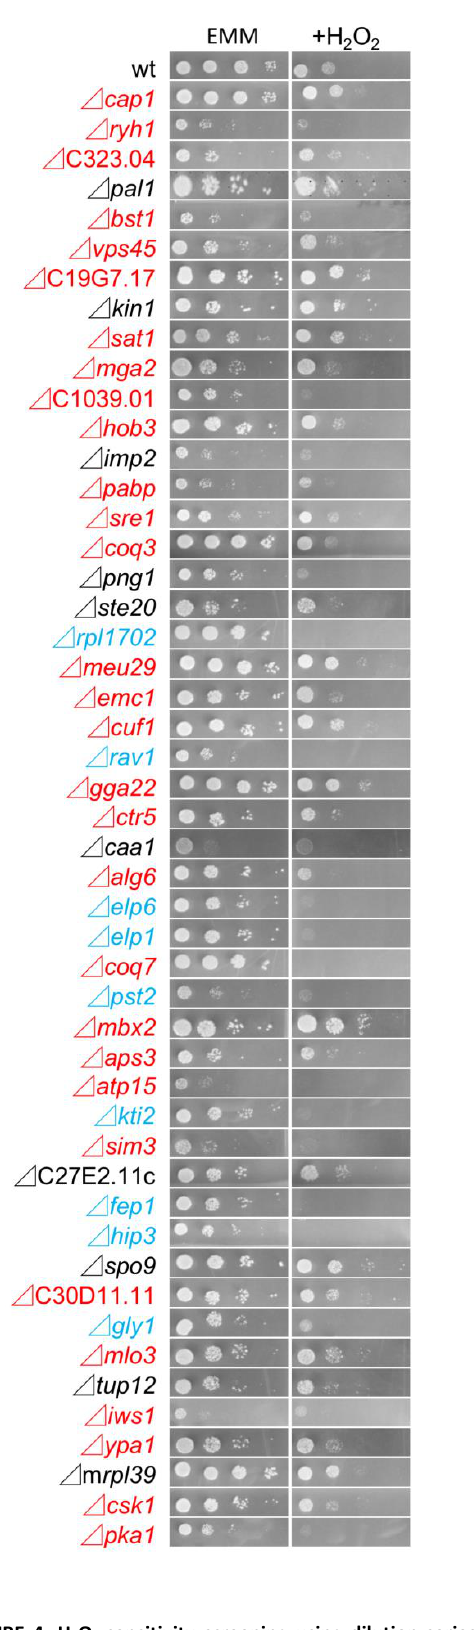
F IGURE 4: H 2 O 2 -sensitivity screening using dilution-series spot assay for the 49 KO strains identified in the third screen . Raw data of chemical genomics screening on the EMM plate with 2 mM H 2 O 2 (EMM , +H 2 O 2